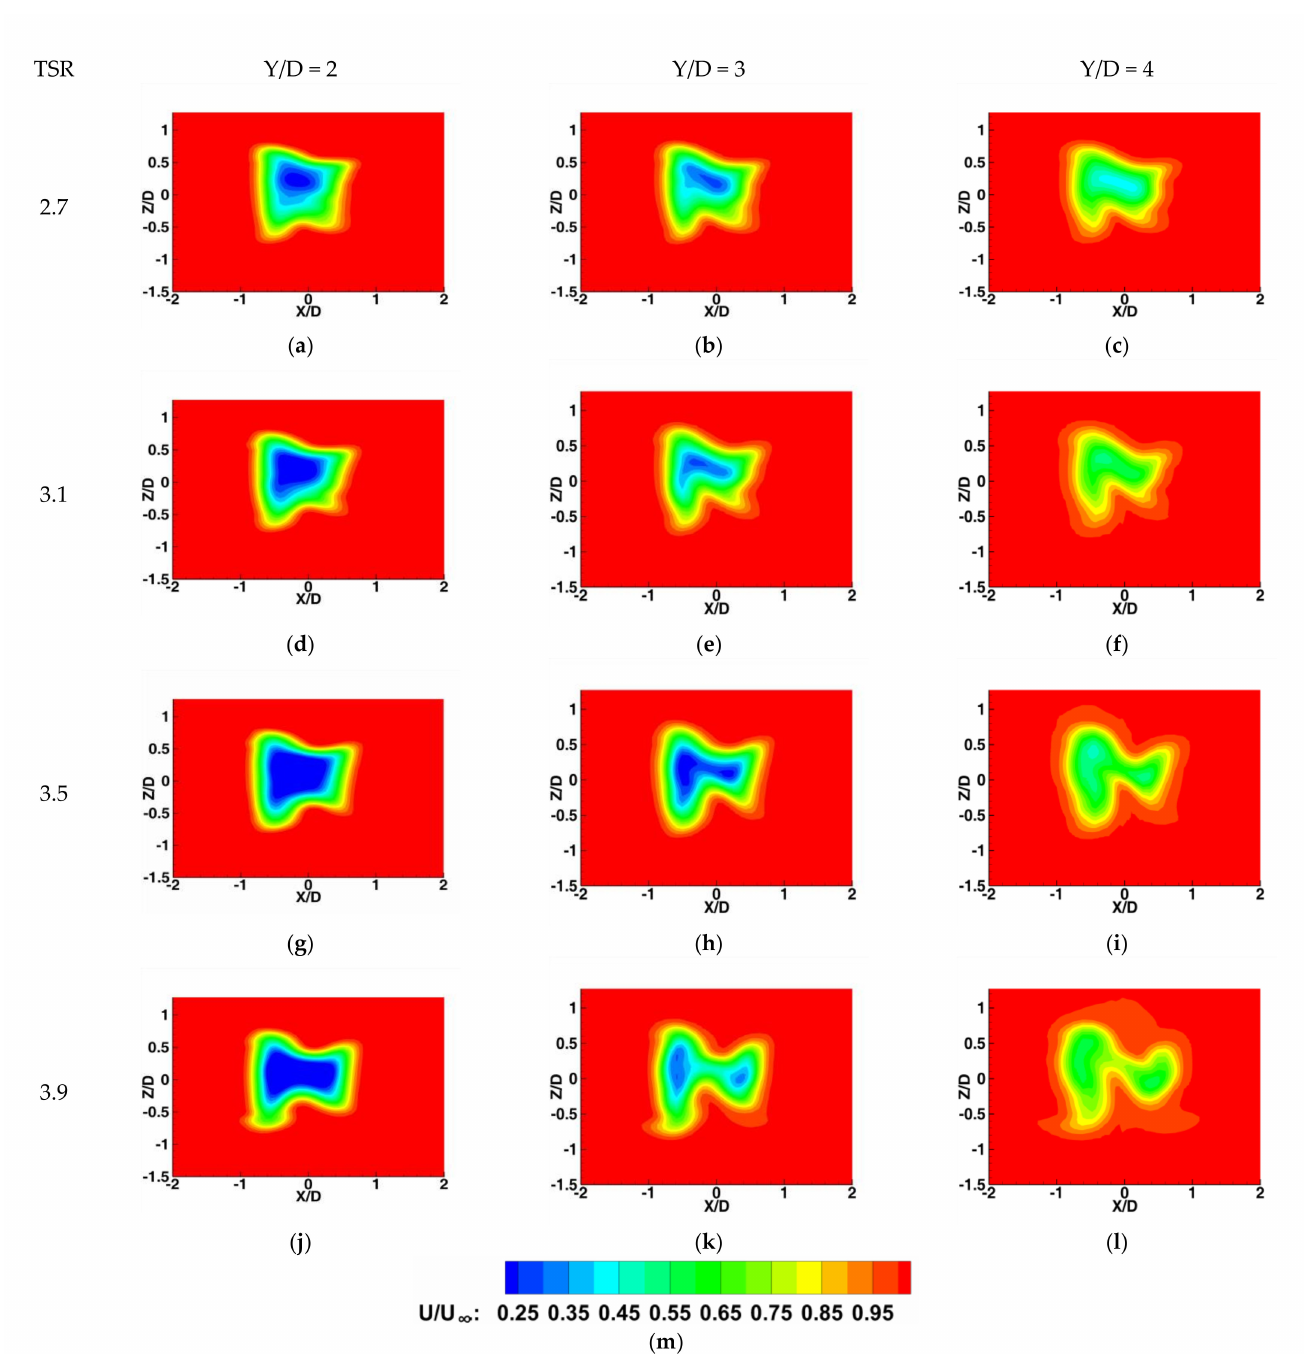
Figure 24. Wake structure for a 90 ◦ helical-bladed VAWT at Y/D of 2 ( a , d , g , j ), 3 ( b , e , h , k ), and 4 ( c , Figure 2. 7 ( a – c ), 3.1 ( d – f ), 3.5 ( g – i ) and 3.9 ( j – l